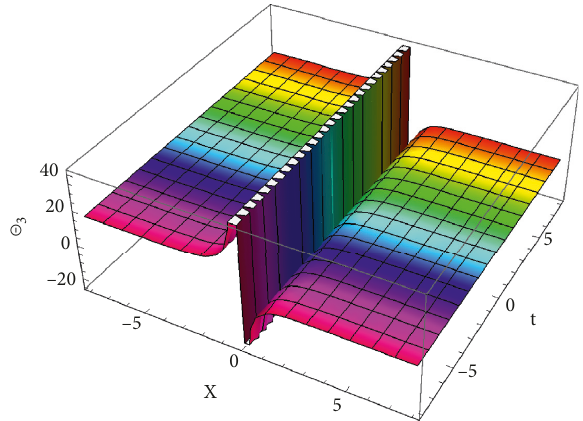
Figure 9: Plots of equations (75), for m � 0, ξ � 0 . 2, λ � 0 . 2, 1